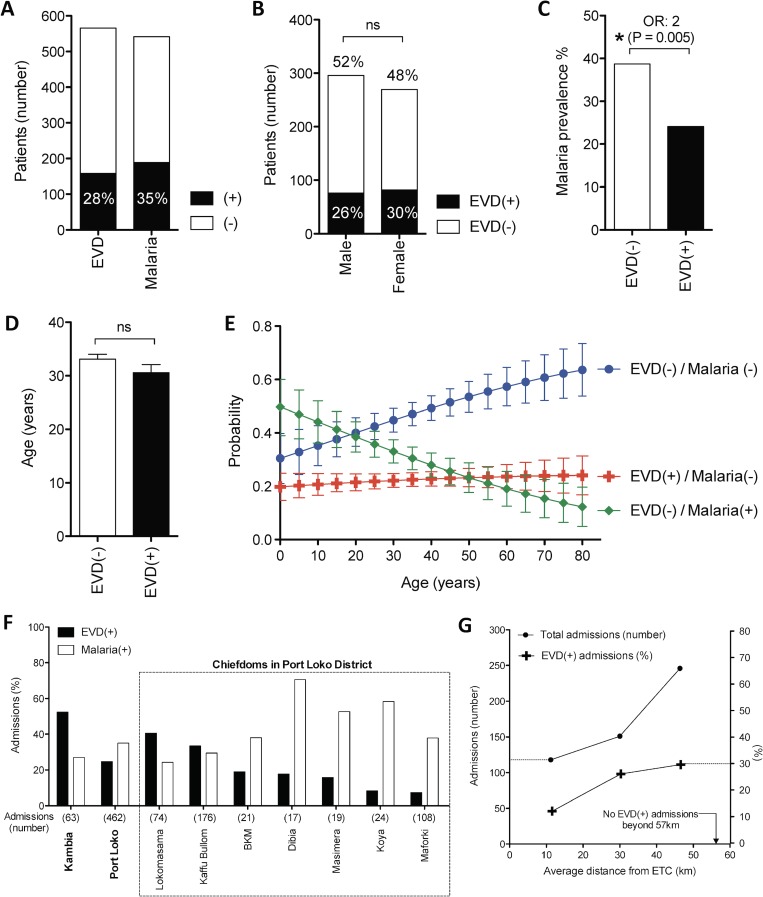
Demographic and epidemiological characteristics of EVD infection.(A) Number of patients according to EVD or malaria test result. (B) Gender distribution of EVD infection. (C) Malaria prevalence among EVD(-) and EVD(+) cohorts. (D) Average age of EVD(-) and EVD(+) cohorts. (E) Probability of testing EVD(+), EVD(-)/malaria(+) or EVD(-)/malaria(-) according to age. (F) Geographical distribution of EVD and malaria prevalence among admissions at the GOAL-Mathaska ETC, Sierra Leone†. (G) Number of admissions and EVD prevalence according to distance of the referred patient from the ETC†. † Representing 525/552 patients, for which EVD status and geographical location is known. *: p<0.05, **: p<0.005, ***: p<0.001, ns: not significant, ETC: Ebola Treatment Centre.